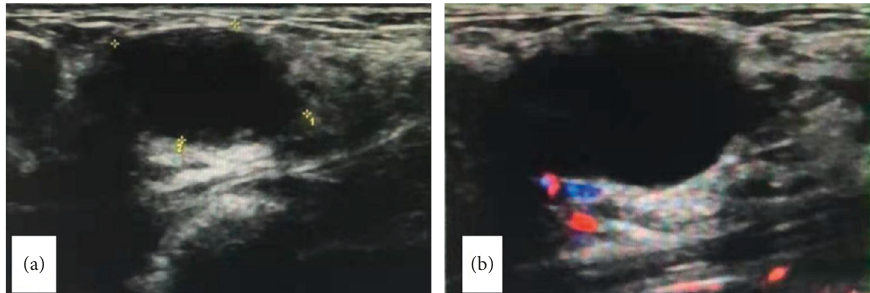
Figure 1: Ultrasonic examination. (a): hypoechoic nodule of the breast with a clear boundary; (b): no obvious blood flow signal in CDFI.